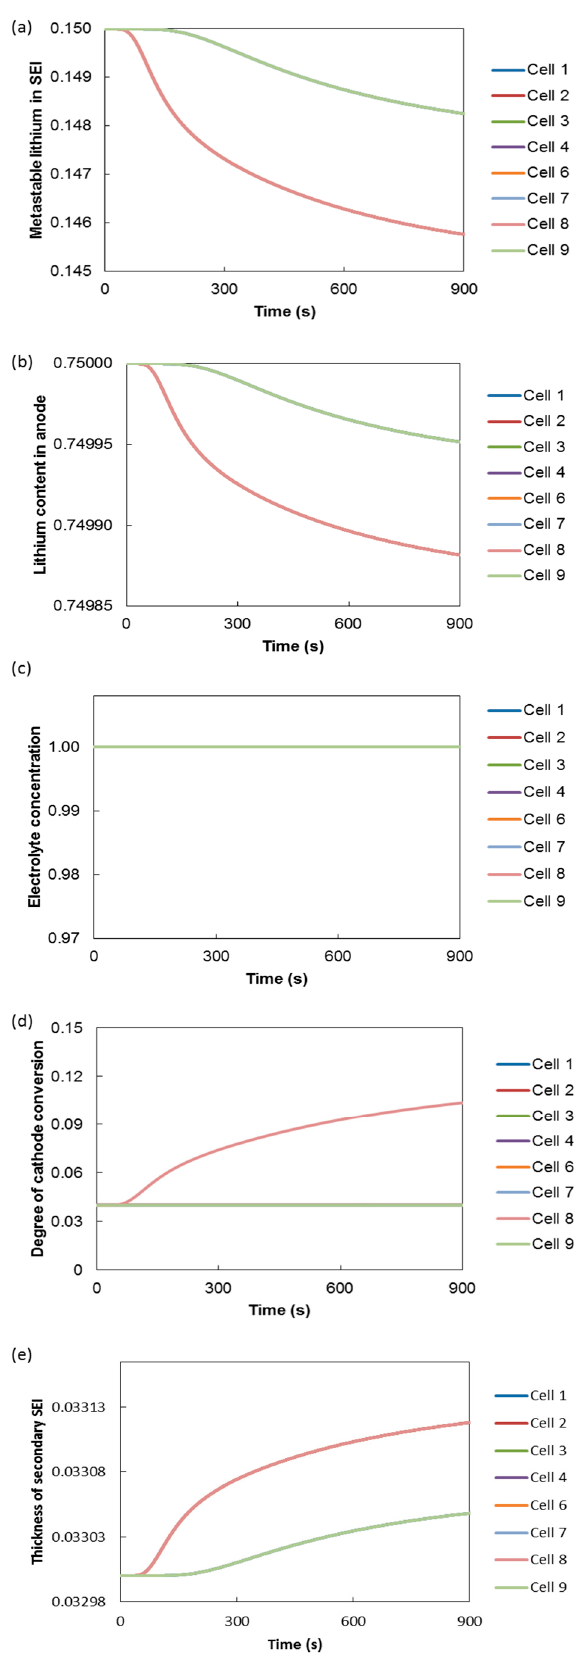
Figure 10. The progress of reaction ( a ) SEI ( b ) anode ( c ) electrolyte ( d ) cathode and ( e ) secondary SEI thickness, in all other cells in the battery module.